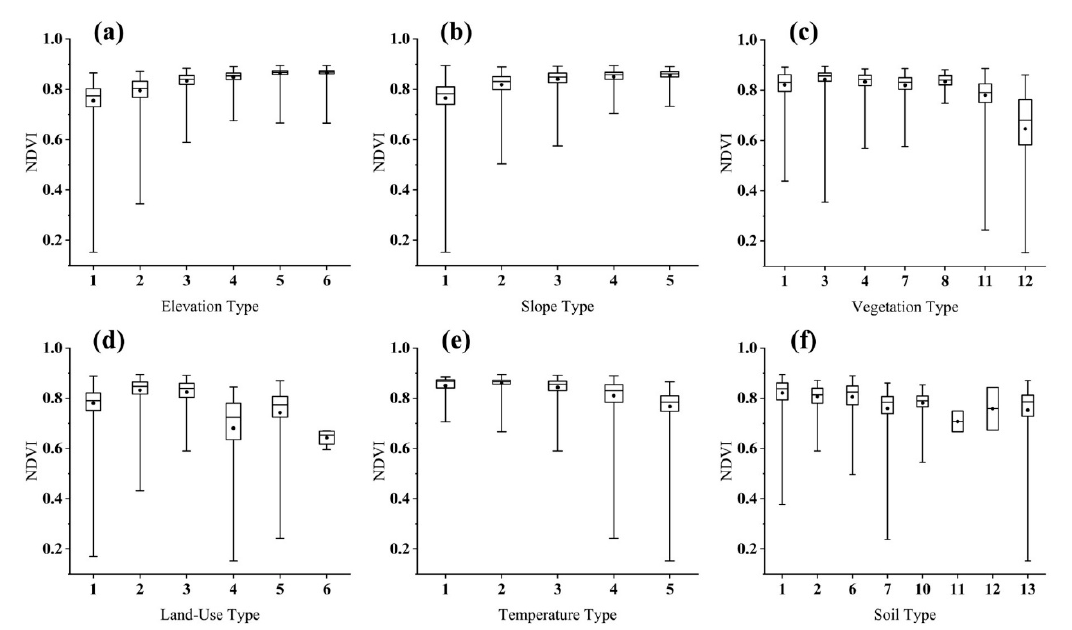
Figure 5. Statistic of the main influencing factors of NDVI: ( a ) elevation, ( b ) slope, ( c ) vegetation type, ( d ) land-use type, ( e ) temperature, ( f ) soil type. Remote Sens. 2020 , 12 , x FOR PEER REVIEW